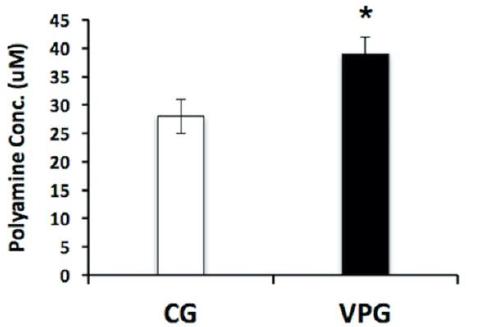
Figure 4. Determination of total polyamine content in skeletal muscle from the VPG vs. CG using a fluorimetric assay. Fluorescence signals proportional to the polyamine concentration in the muscle biopsies were obtained from three technical measures in five independent biological replicates. Results are represented as the mean ± SD. * p < 0.05.